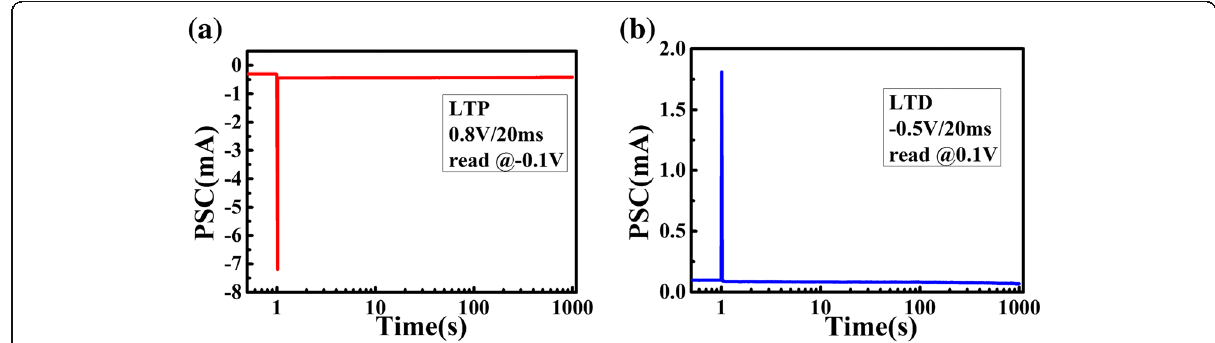
Fig. 6 a The retention characteristics of electrical synapse under positive programing pulse, indicating the long-term potential behaviors. b In LTD process, the post-synaptic current could be inhibited under a single negative pulse ( − 0 .5V, 20 ms) and the conductance state could stay stable for over 1000